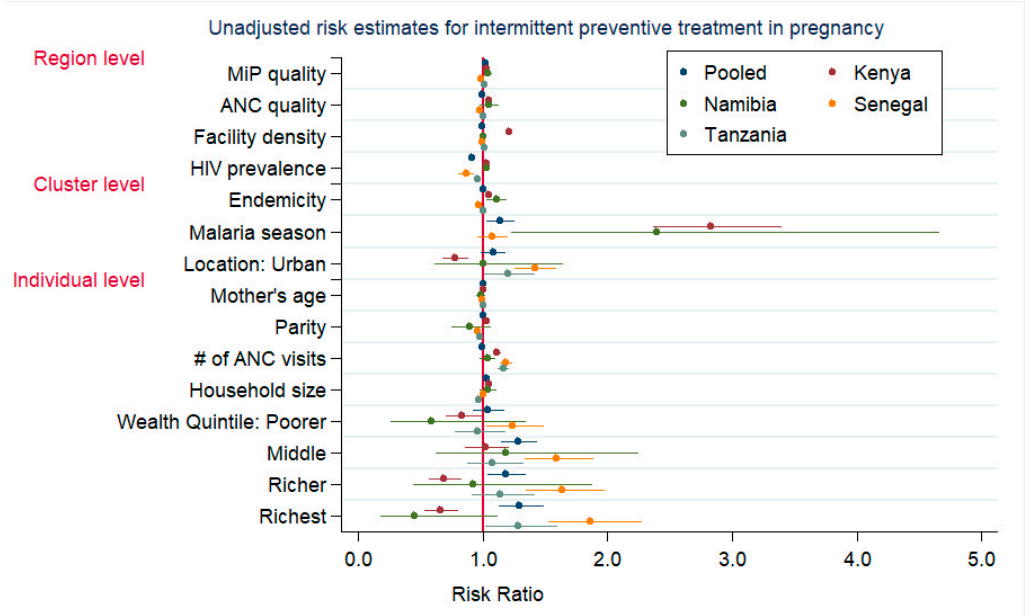
Figure 1. Unadjusted risk estimates for intermittent preventive treatment in pregnancy. Note: Unadjusted risk estimates of mother’s educational level not shown. Table 3. Adjusted multilevel mixed effects modified Poisson results for intermittent preventive treatment in pregnancy uptake.